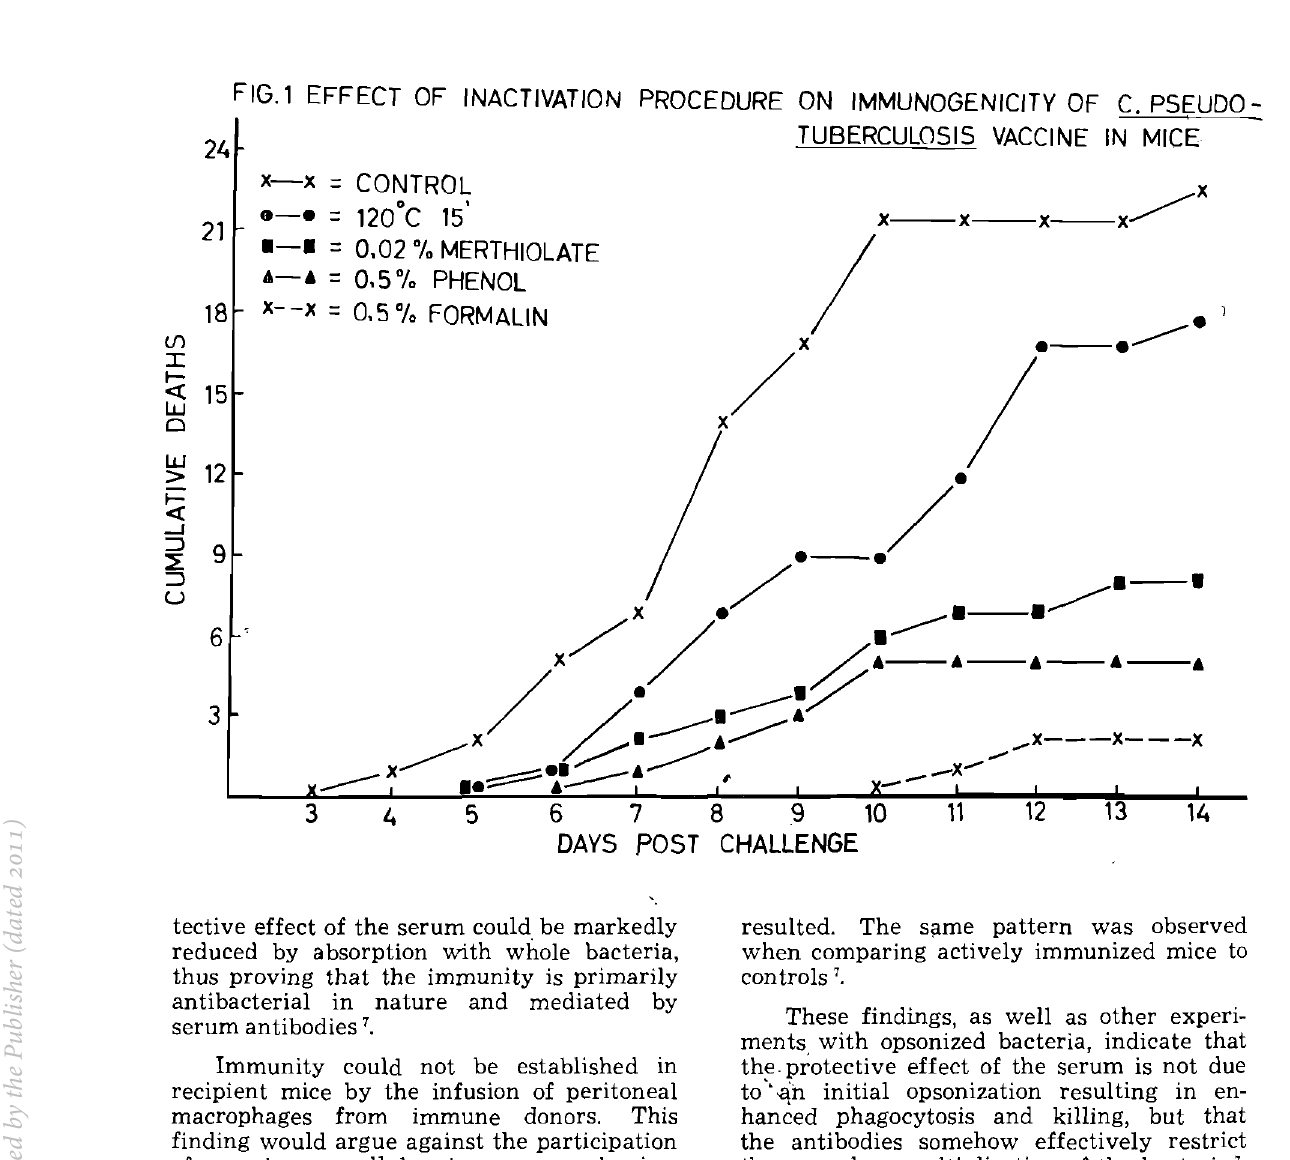
FIG.l EFFECT OF INACTIVATION PROCEDURE ON IMMUNOGENICITY OF C,